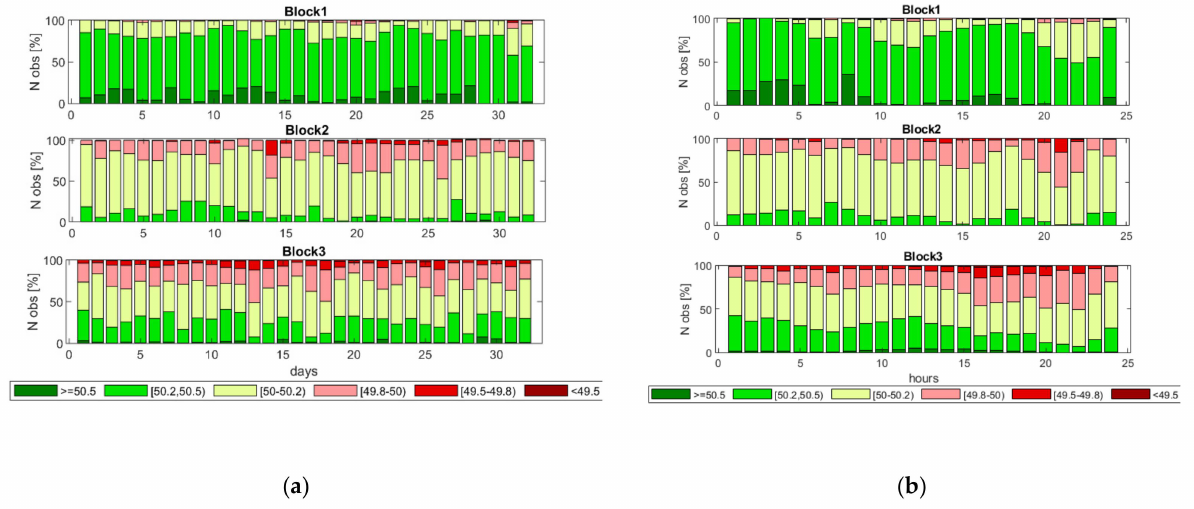
Figure 4. The daily and mean daily frequency profiles of the three blocks. Block 1 was sampled at 60 s, Block 2 at 4 s and Block 3 at 10 s.